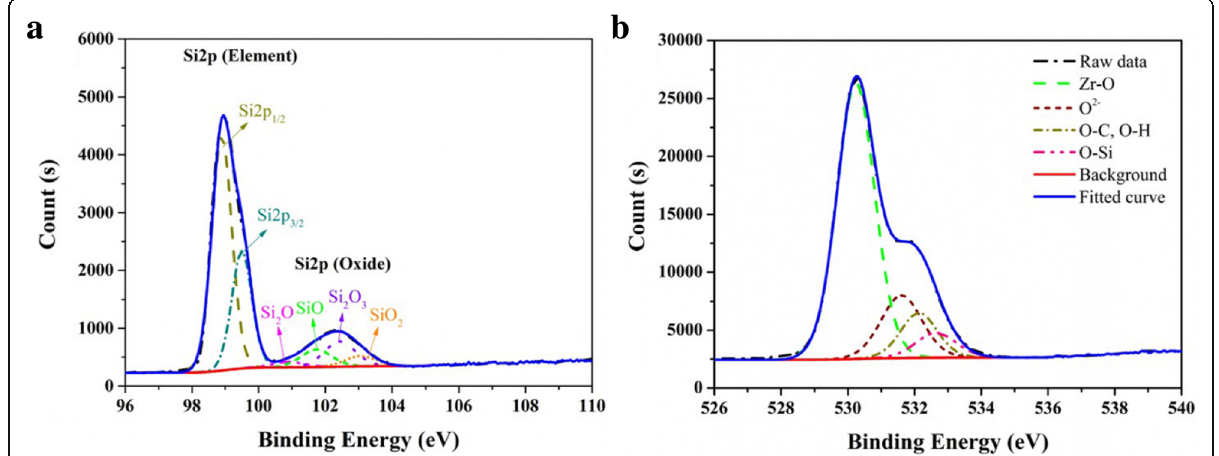
Fig. 8 The fine spectra of Si 2p and O 2s for the ZrO 2 film deposited at